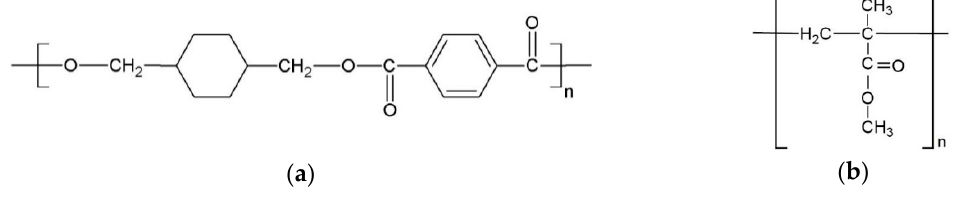
Figure 2. Chemical structure of ( a ) polyethylene terephthalate glycol-modified (PETG), and ( b ) polymethyl methacrylate (PMMA).